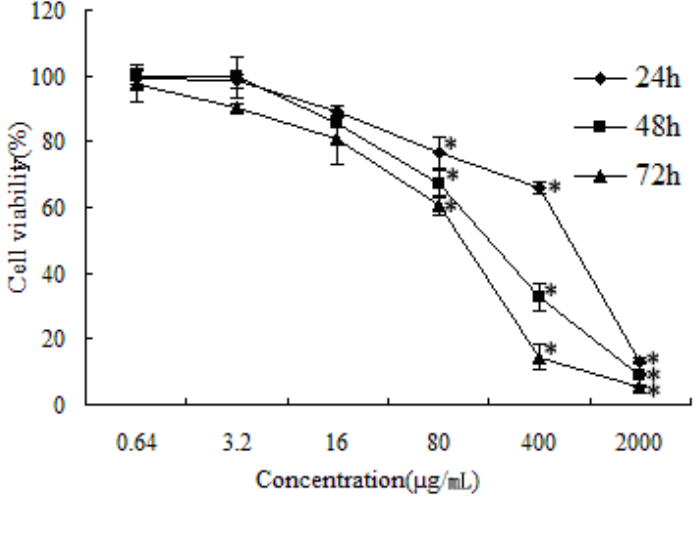
Figure 1. Effect of SFE-CO extract towards SMMC-7721 cells as determined by the MTT 2 assay. The values are representative of three separate experiments, data are presented as mean ± S.D. * p < 0.05; p value compared with the control